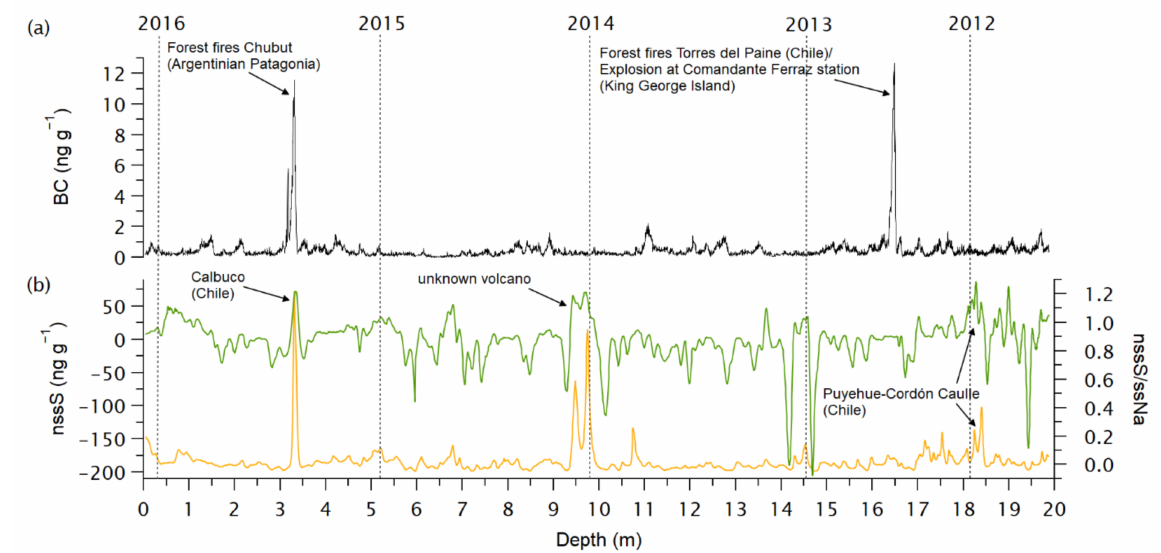
Figure 5. High-resolution depth profiles of ( a ) BC (black), ( b ) non-sea-salt sulphur (nssS; green) and the non-sea-salt sulphur–sea-salt sodium ratio (nssS/ssNa; orange) of firn core OH-12. Southern hemispheric events assigned to the remarkable maxima identified in the BC, nssS and nssS/ssNa records are indicated (for details, see Section